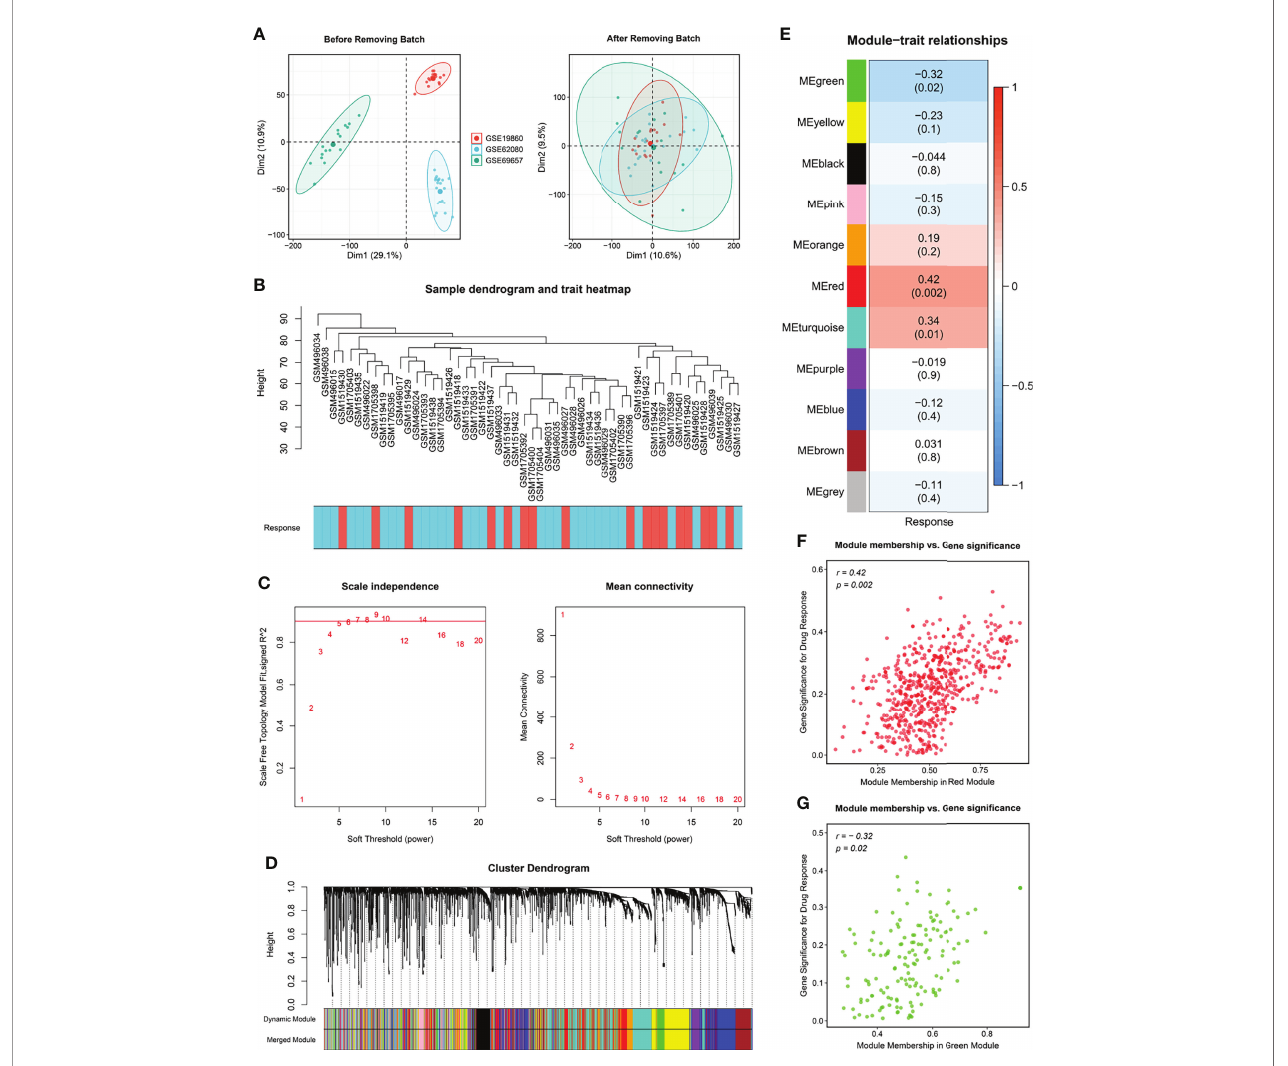
FIGURE 2 | Modules relevant to chemotherapy response. (A) Raw data from GSE19860, GSE62080 and GSE69657 were batch corrected to form a Meta cohort. (B) Remaining samples after discarding outliers. (C) Scale-free topological indices at various soft-thresholding powers. (D) Gene clustering diagram based on hierarchical clustering under optimal soft-thresholding power. (E) Correlations between gene modules and chemotherapy response. (F, G) The correlation between the key modules (red, F ; green, G ) memberships and the gene signi fi cance for chemotherapy